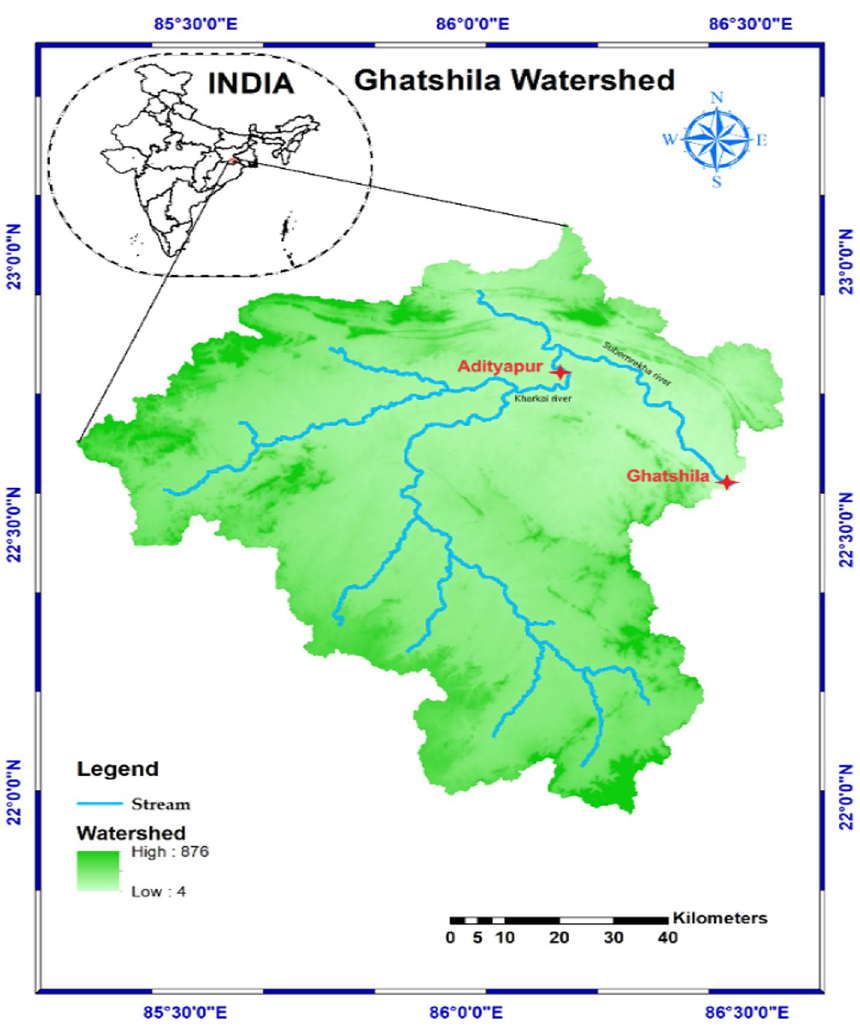
Fig. 1 Location map of